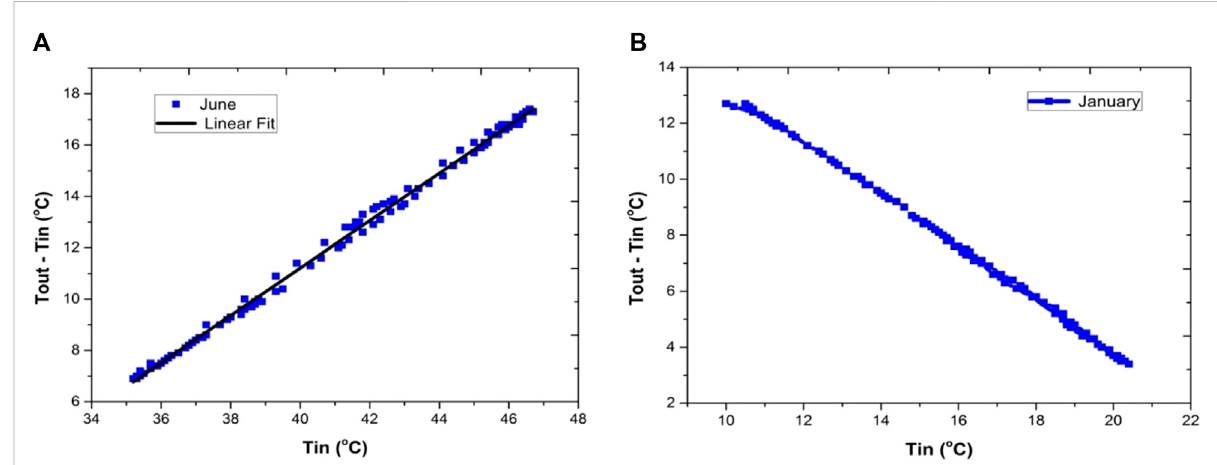
FIGURE 11 Variation of temperature raise with inlet air temperature during (A) January and (B) June.